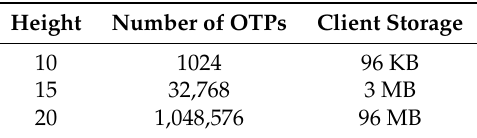
Table 2. The relationship between the height of the Merkle tree, the number of OTPs, and the client storage (the size of the hash value and the nonce is 32